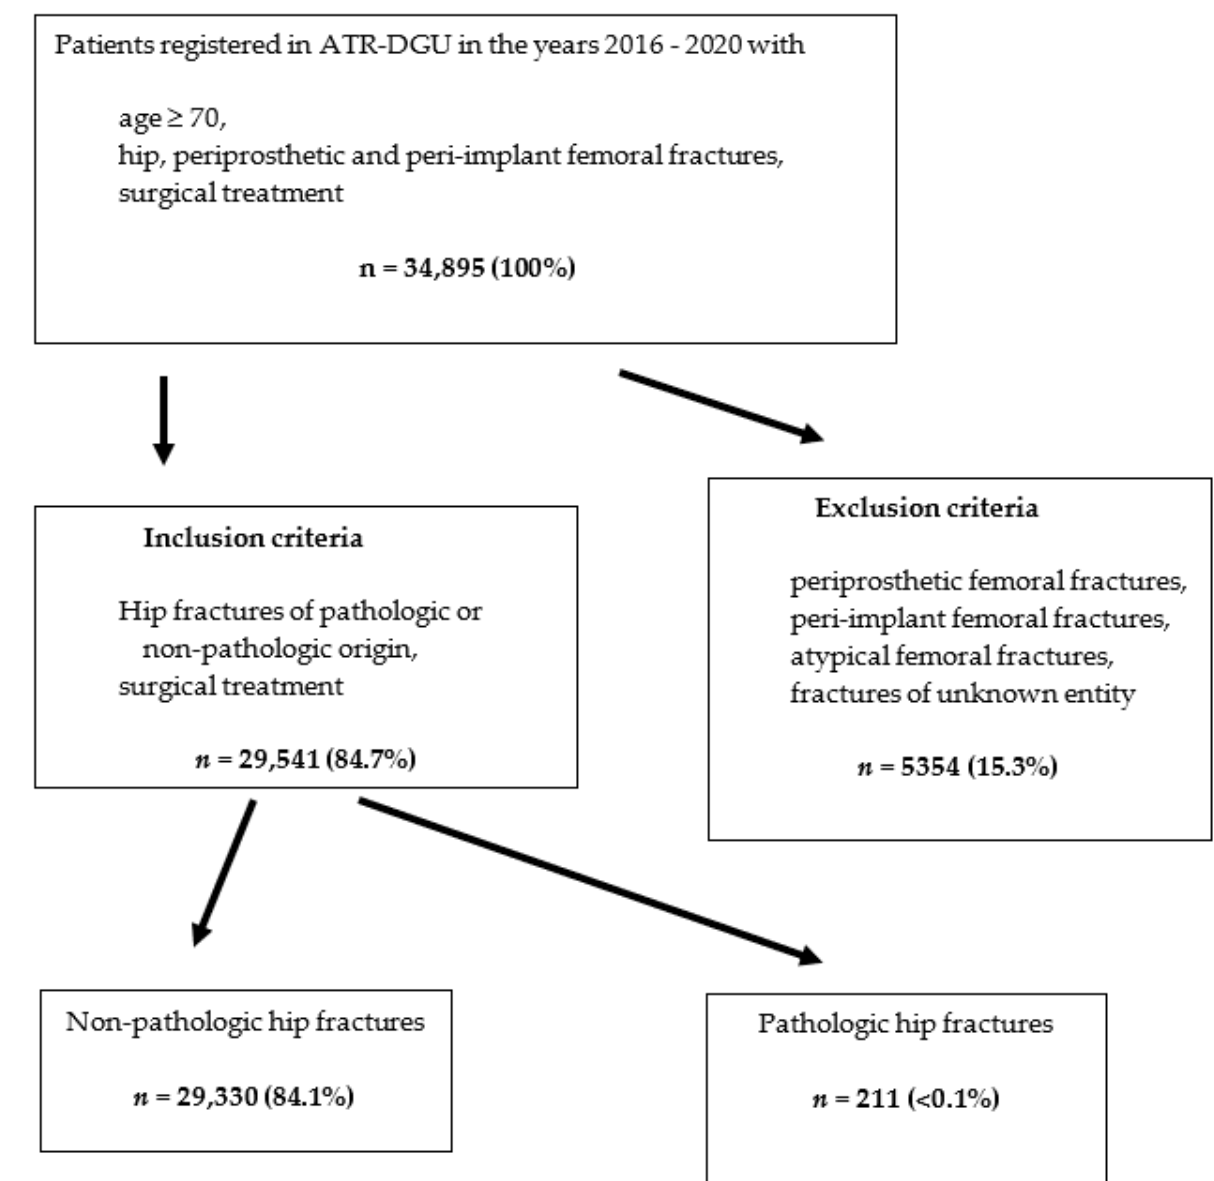
Figure 1. Flow sheet of the included population.